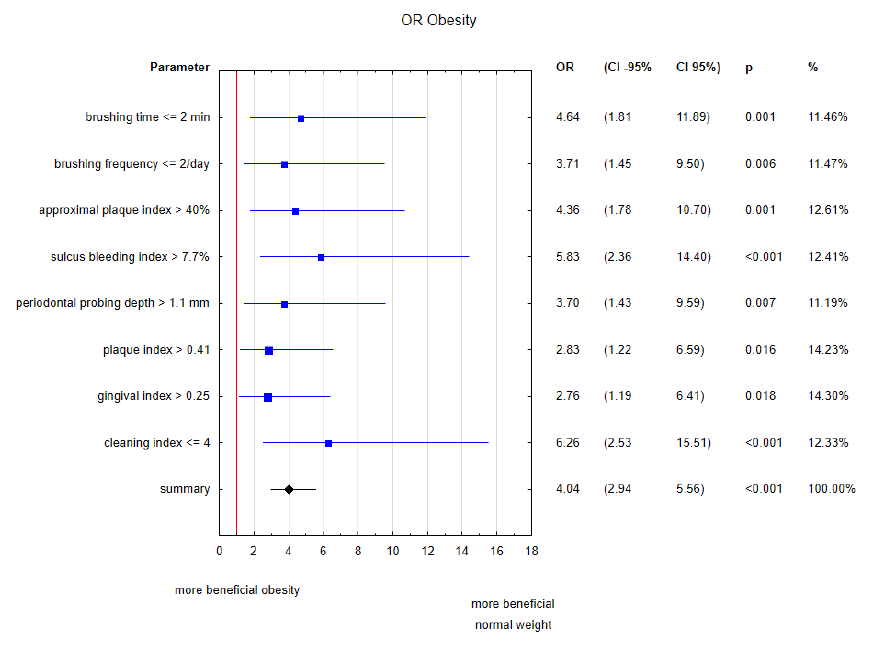
Figure 1. Forest plot of assessed dental parameters in patients with poor oral hygiene concerning odds ratios for obesity.